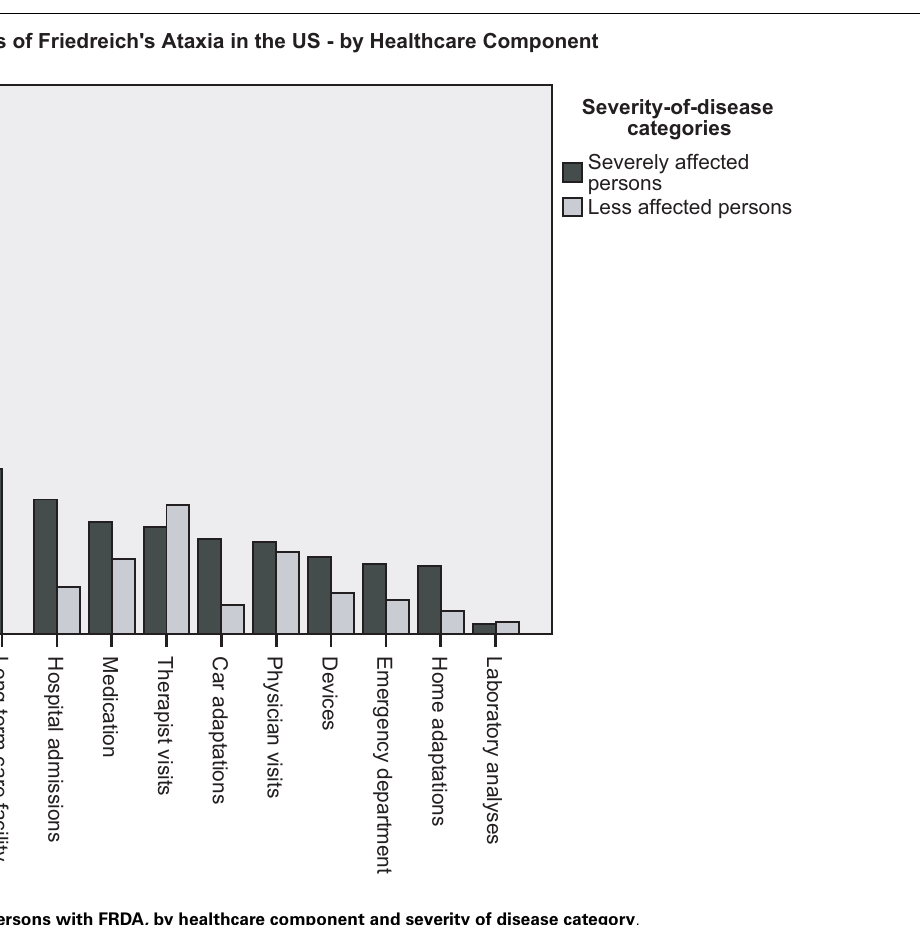
where 59% of the respondents saw a physiotherapist at least one to two times a year and 24% saw the physiotherapist at least monthly. Eighty seven percent of the respondents never saw a speech therapist and none used this type of therapy on a regular